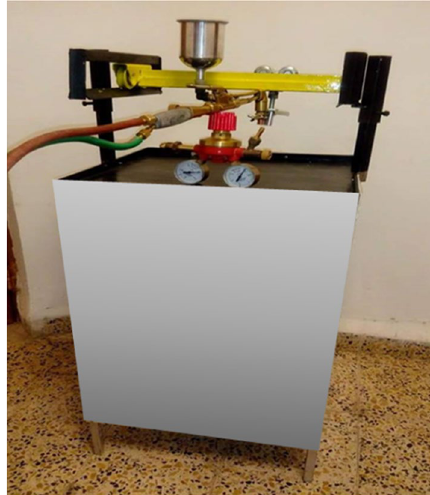
Figure 2. High velocity oxy-fuel system (HVOF) 15 .